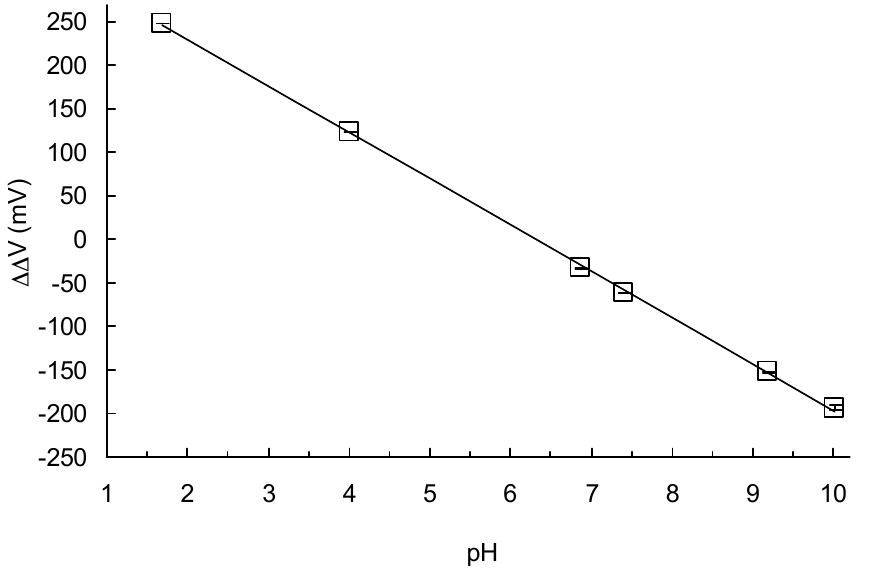
Figure 6. Calibration function of a microfluidic pH measurement device. Average error ± S.D. The S.D. values were 0.18, 0.58, 0.61, 0.15, 0.83, and 2.04 (mV) from the left to right.